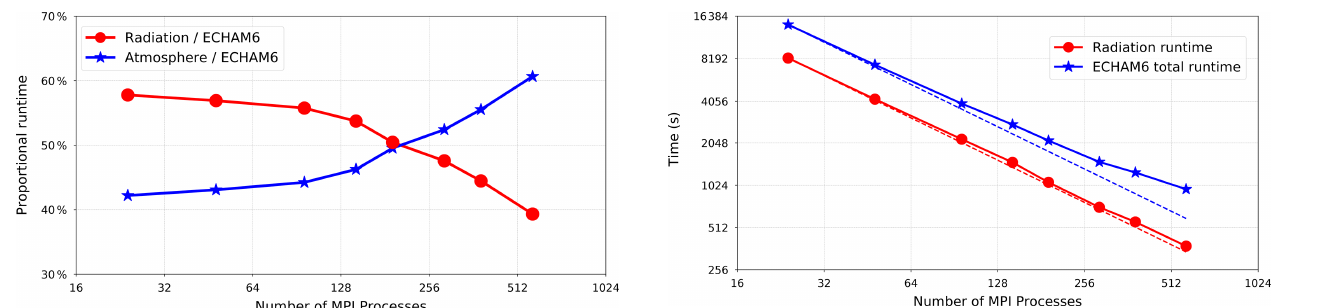
Figure 2. The relative time contribution of radiation calculations in ECHAM6 (using the classical radiation scheme) in the CR simula- tions.